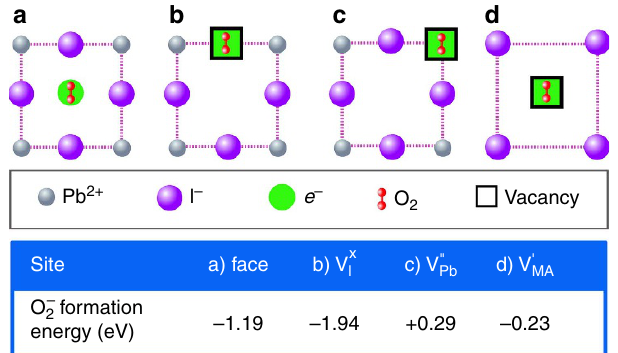
Figure 5 | Lattice sites for superoxide formation. Schematic representation of possible O 2 binding and reduction sites in CH 3 NH 3 PbI 3 ([001] plane) and corresponding superoxide formation energy: ( a ) face site neighbouring four iodide ions, ( b ) neutral iodide vacancy (with a photoelectron on the defect site) and negatively charged lead ( c ) and methylammonium ( d ) vacancies (with no photoelectron on them since this was found to be unphysical).